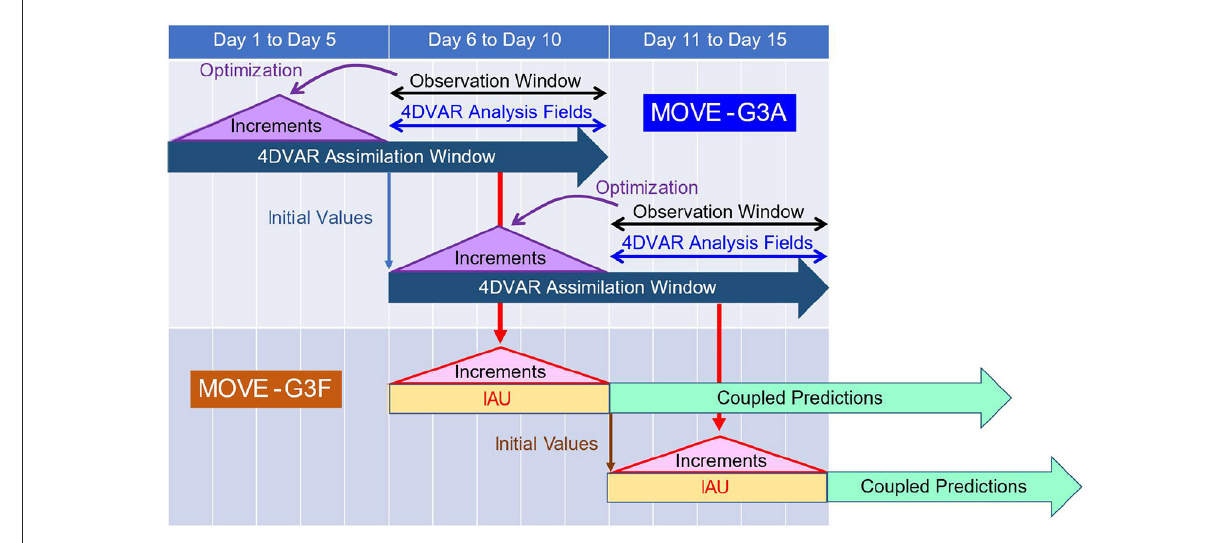
FIGURE1 Schematic figure of the data assimilation process of